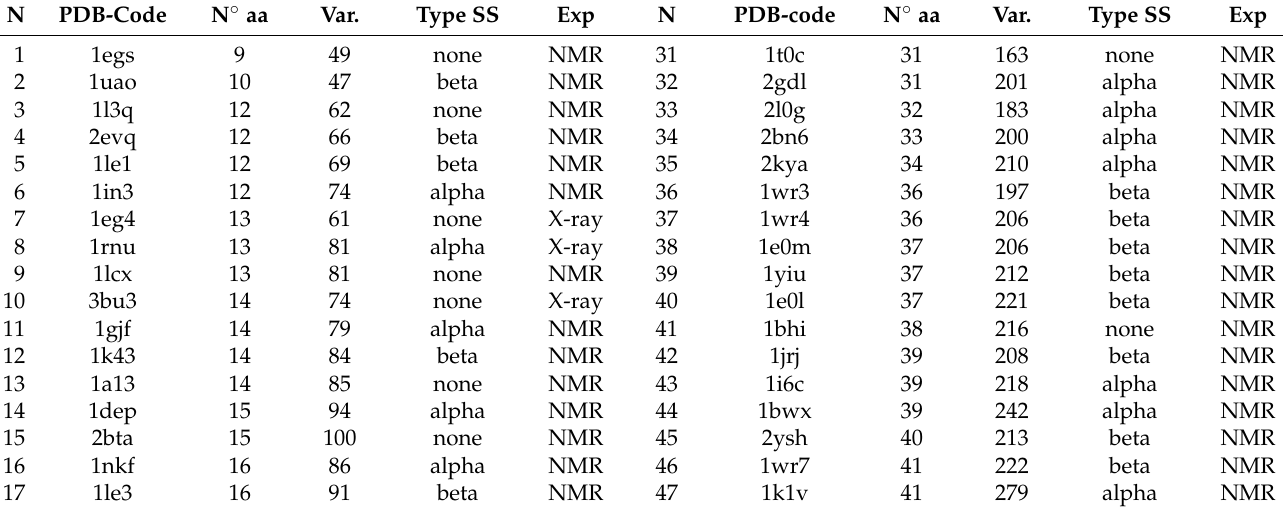
Table 1. Peptides